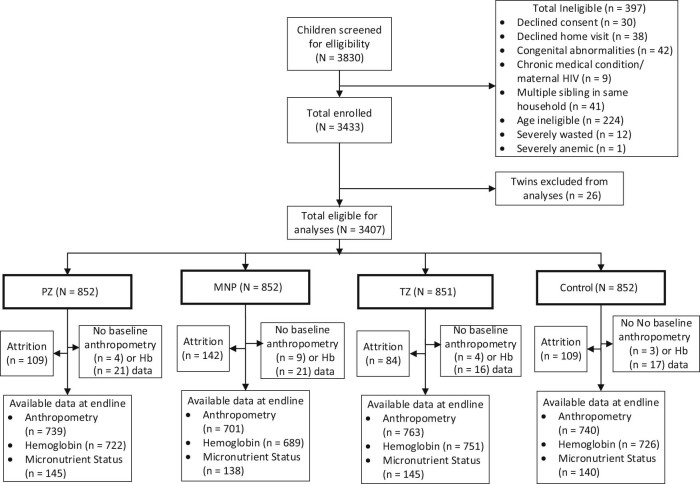
Consort diagram of study participant progression through the growth and biochemical assessments in the Lao Zinc Study. The micronutrient powder group received 1 micronutrient powder sachet daily (vitamin A [400 µg of retinol equivalents], thiamin [0.5 mg], riboflavin [0.5 mg], niacin [6 mg], vitamin B6 [0.5 mg], folic acid [150 µg of dietary folate equivalents], cyanocobalamin [0.9 µg], ascorbic acid [30 mg], cholecalciferol [5 mg], dl-α-tocopheryl acetate [5 mg of tocopherol equivalents], copper sulfate anhydrous [to provide 0.56 mg copper], potassium iodate [to provide 90 µg iodine], ferrous fumarate [to provide 6 mg of iron], selenium selenite [to provide 17 µg of selenium], zinc gluconate [to provide 10 mg of zinc]) and placebo tablet (1 per day for 10 days) during diarrhea episodes. The preventive zinc group (preventive zinc supplements) received 1 zinc tablet (7 mg/d) daily and placebo tablet (1 per day for 10 days) during diarrhea episodes. The therapeutic zinc group (therapeutic zinc supplements) received 1 placebo tablet daily and a 20-mg zinc tablet (1 per day for 10 days) during diarrhea episodes. Controls received 1 placebo powder sachet daily and placebo tablet (1 per day for 10 days) during diarrhea episodes. All children received ORS during diarrhea episodes, regardless of group allocation.